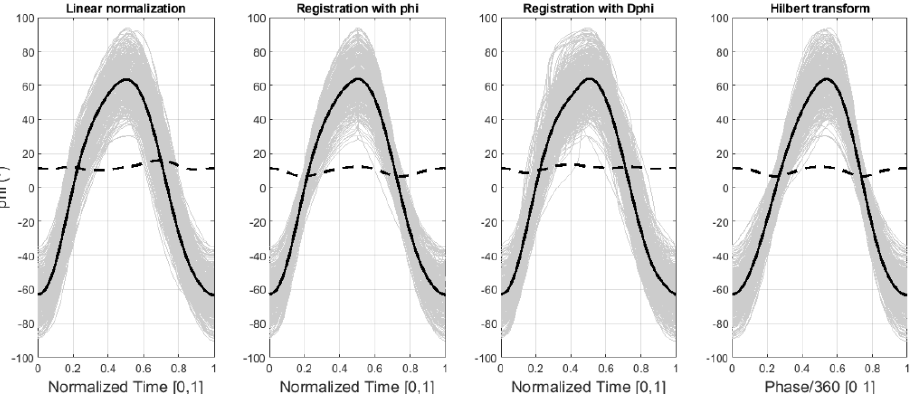
Figure 3. Normalized angle (phi) curves for the four methods compared, together with their functional means (solid black line) and functional standard deviations (dashed black line).